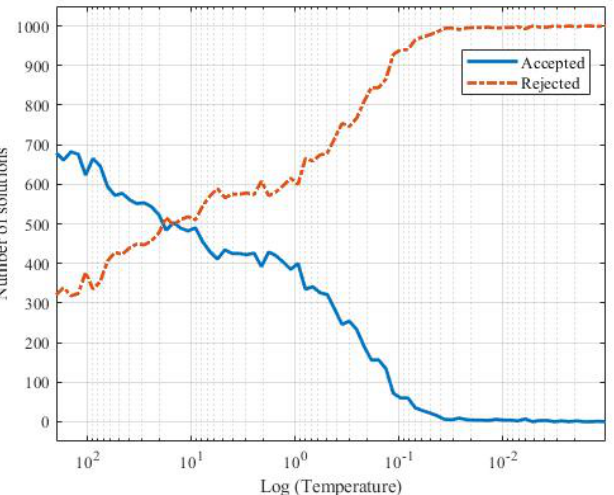
Figure 3. Number of accepted and rejected new candidates versus temperature. This graph shows that a reasonable initial temperature is T 0 = 100 where 60% of the new candidates are accepted.